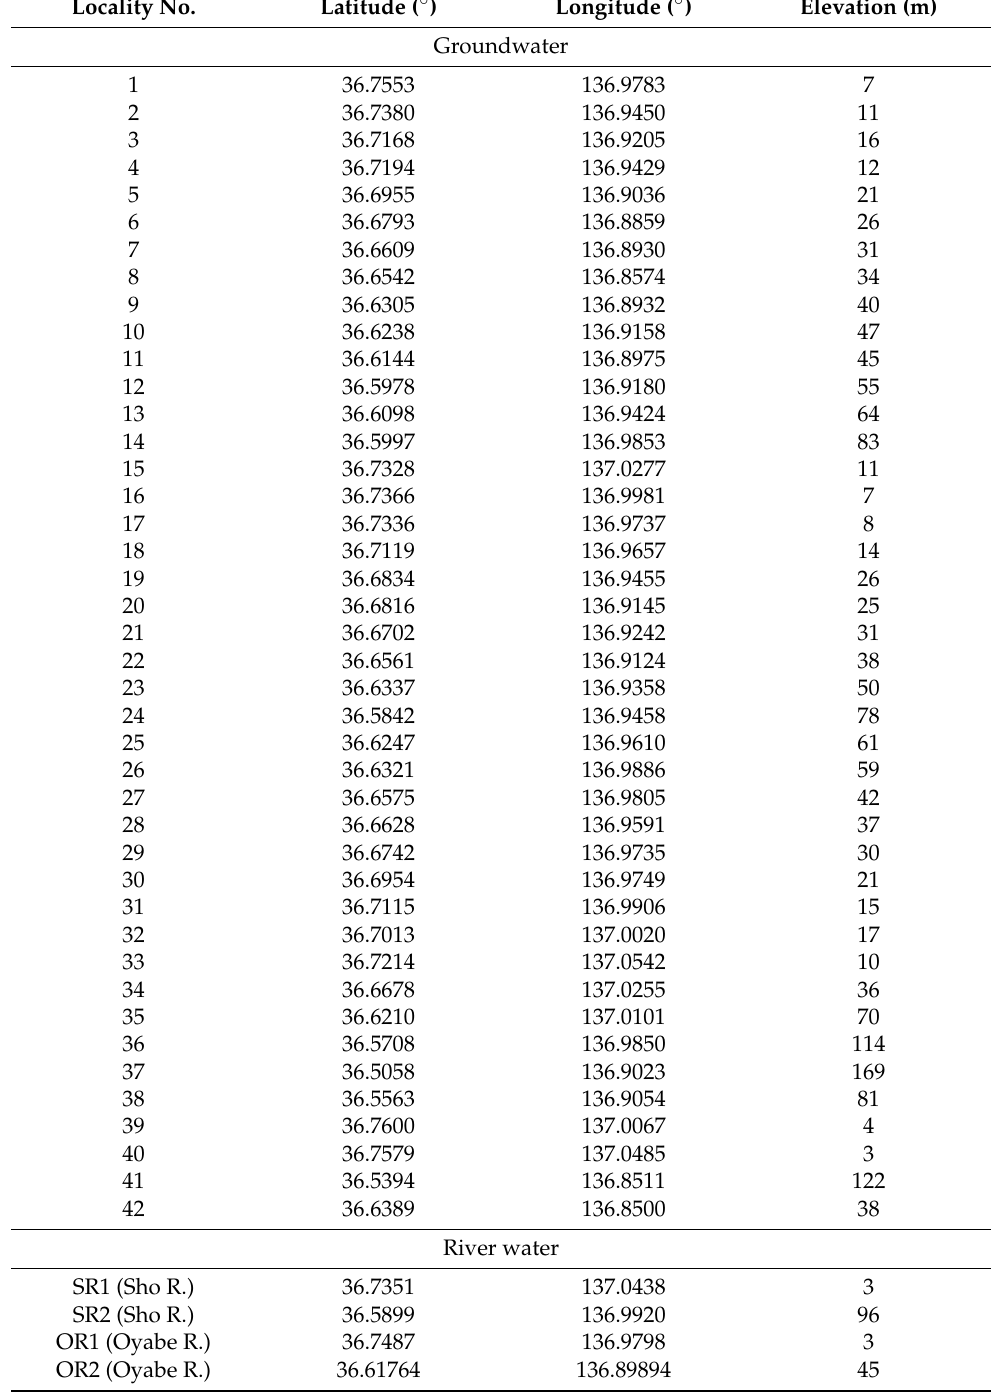
isotope ratio after washing three times with sample water. Because the groundwater and river water samples were colorless and transparent, filtration and acid treatment were not carried out in the field. Water temperature, pH, electric conductivity (EC), and oxidation– reduction potential (ORP) were measured at the sampling site using a thermometer (YI Chun waterproof digital thermometer, China), a pH meter (TOA HM-31P, Japan), an EC meter (TOA CM-31P, Japan), and an ORP meter (TOA RM-30P, Japan), respectively. Table 1. Sample sites for groundwater and river water in the Sho River alluvial fan. Locality No. Latitude ( ◦